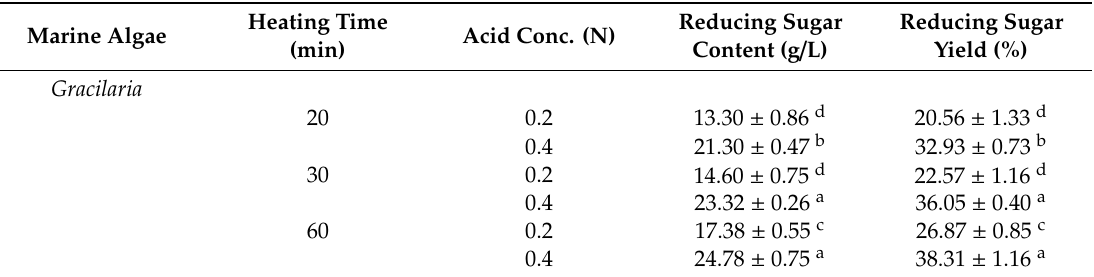
Table 2. The e ff ects of various heating times and acid concentrations on the production of reducing sugar from hydrochloric acid hydrolysis of 10% ( w / v ) marine